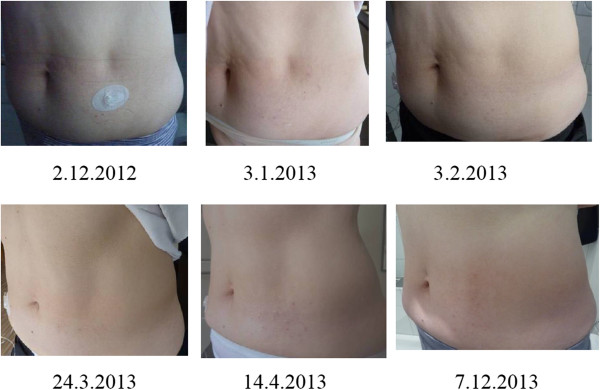
Development of localized involutional lipoatrophy at the insulin infusion site, before (2 December 2012) and after resumption of 10mg prednisone daily (the end of December 2012 to mid-March 2013, tapered off until 24 March 2013). No prednisone from 25 March 2013 until 31 December 2013.